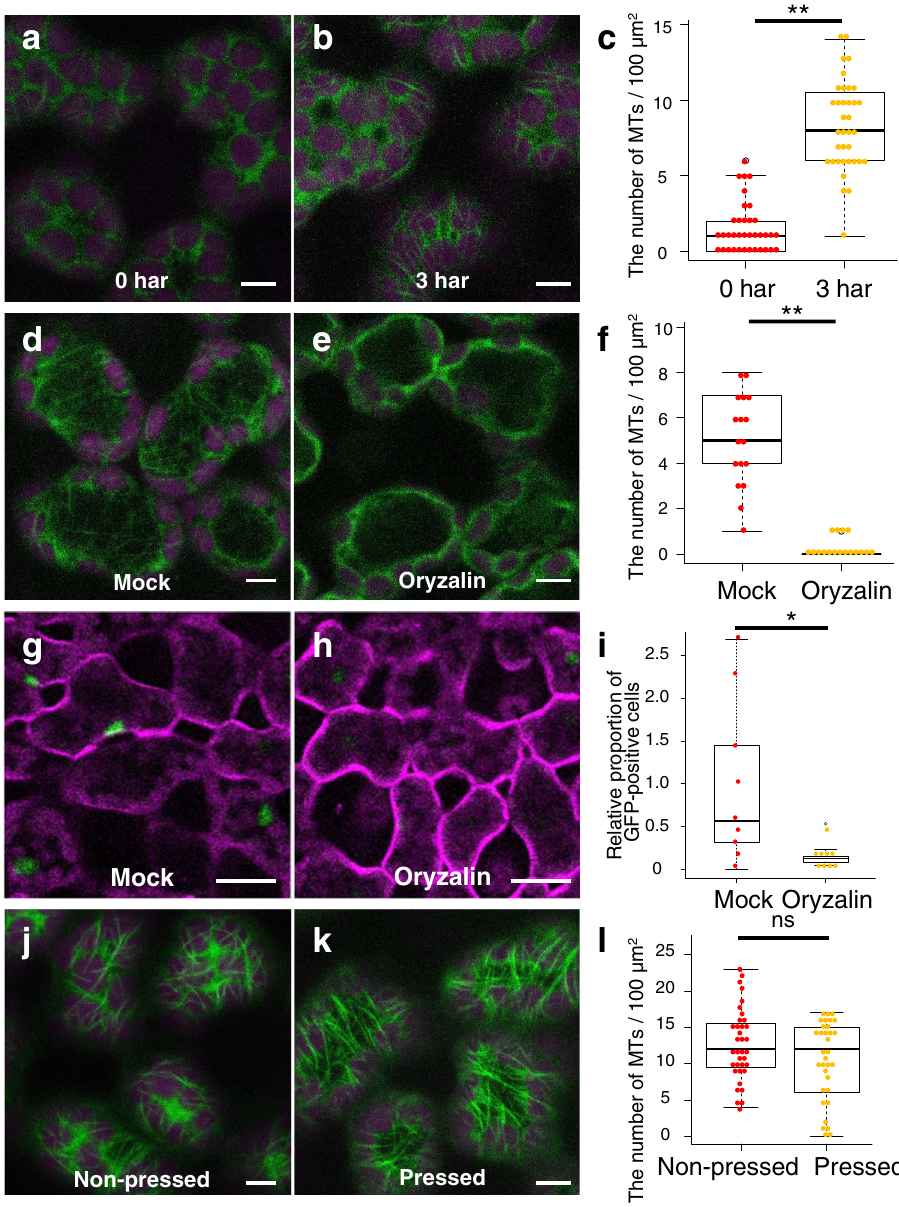
Fig.3|Corticalmicrotubuleformationwasrequiredfor ATML1 derepressionin the outermost mesophyll. a , b 35S-GFP-TUA6 signals in mesophyll cells of 9-day- oldseedlingswereobserved rightafter( a )andthreehoursafter( b )removalofthe epidermis (0harand 3 har, respectively; har, hour after removalofthe epidermis). c Quanti fi cation of the cortical microtubule (MT) density in mesophyll cells of 9- day-old 35S-GFP-TUA6 seedlings at0 harand 3 har. n =36 cells from 12 biologically independent leaves (three cells from each leaf). Two-tailed Welch ’ s t-test was used (** P <0.01). d , e GFP-TUA6 protein localization in mesophyll cells of 9-day-old seedlings grown in liquidMSmedium supplementedwith 0.1%DMSO ( d ;Mock)or 30 µ M oryzalin ( e ; Oryzalin) for three hours after epidermis removal. f The cortical microtubule density in the outermost mesophyll cells was quanti fi ed in mock and oryzalin-treated 35S-GFP-TUA6 leaves at three har. n =18 cells from six biologically independent leaves (three cells from each leaf). Two-tailed Welch ’ s t -test was used